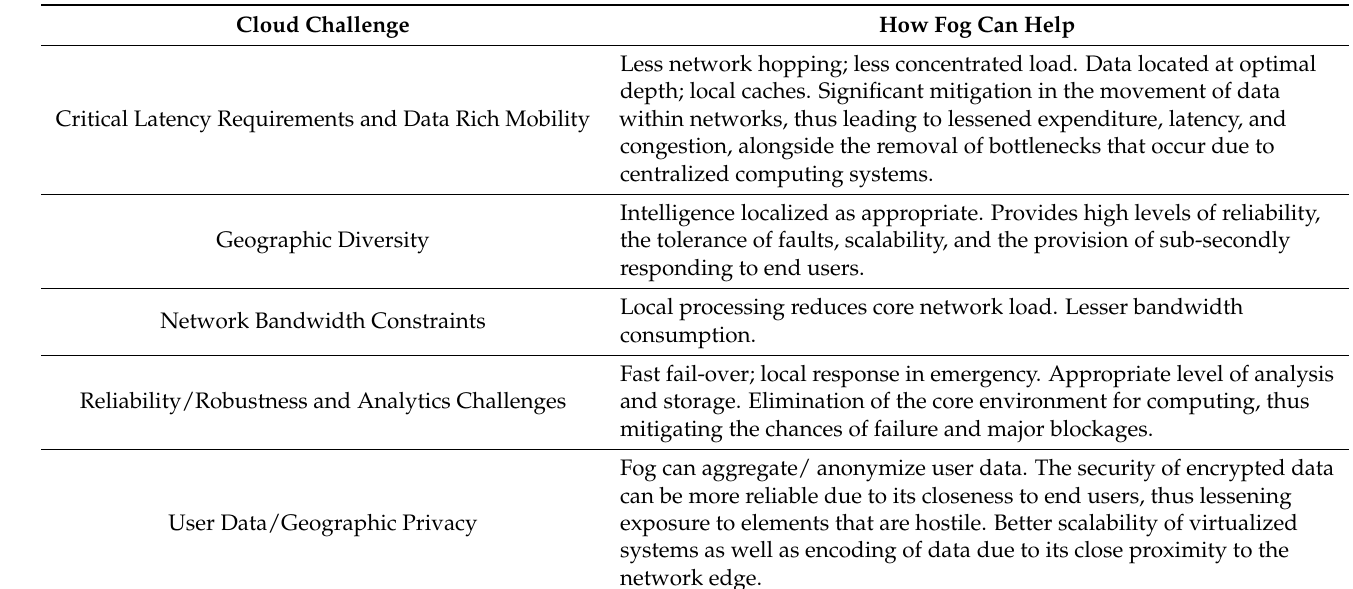
Table 1. How Fog can help cloud computing